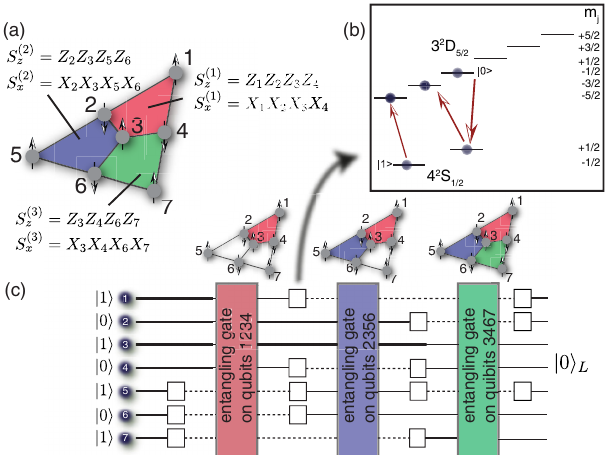
FIG. 1. Schematics of the implemented seven-qubit quantum error correcting code and the encoding sequence. (a) One logical qubit is encoded in seven physical qubits forming a two- dimensional triangular planar structure of three plaquettes. The code space is defined as the simultaneous þ 1 eigenspace of a set of six four-qubit stabilizer operators associated with the plaque- ttes. (b) Physical qubits are encoded in (meta)stable electronic states of a string of seven 40 Ca þ ions. The computational sub- space of each physical qubit is spanned by the two electronic states m − 1 = 2 Þ ( j 1 i ) and 3 2 D m − 1 = 2 Þ ( j 0 i ). Another 4 2 S 1 = 2 ð j ¼ 5 = 2 ð j ¼ pair of states [ 3 2 D 5 = 2 ð m j ¼ − 5 = 2 Þ and 3 2 D 5 = 2 ð m j ¼ − 3 = 2 Þ ] is used to spectroscopically decouple individual ion qubits. Red arrows indicate sequences of pulses that are applied to realize this coherent decoupling (see Ref. [16] for more details). Decoupled ions [indicated by dashed lines in (c)] ideally will not participate in subsequent dynamics, until they are recoupled, i.e., coherently transferred back into the computational subspace [solid lines in (c)]. This technique enables the application of entangling gate operations, which, in this setup, are implemented by illuminating the entire ion string by a global laser beam [18], to subsets of four qubits belonging to a given plaquette. (c) The logical qubit